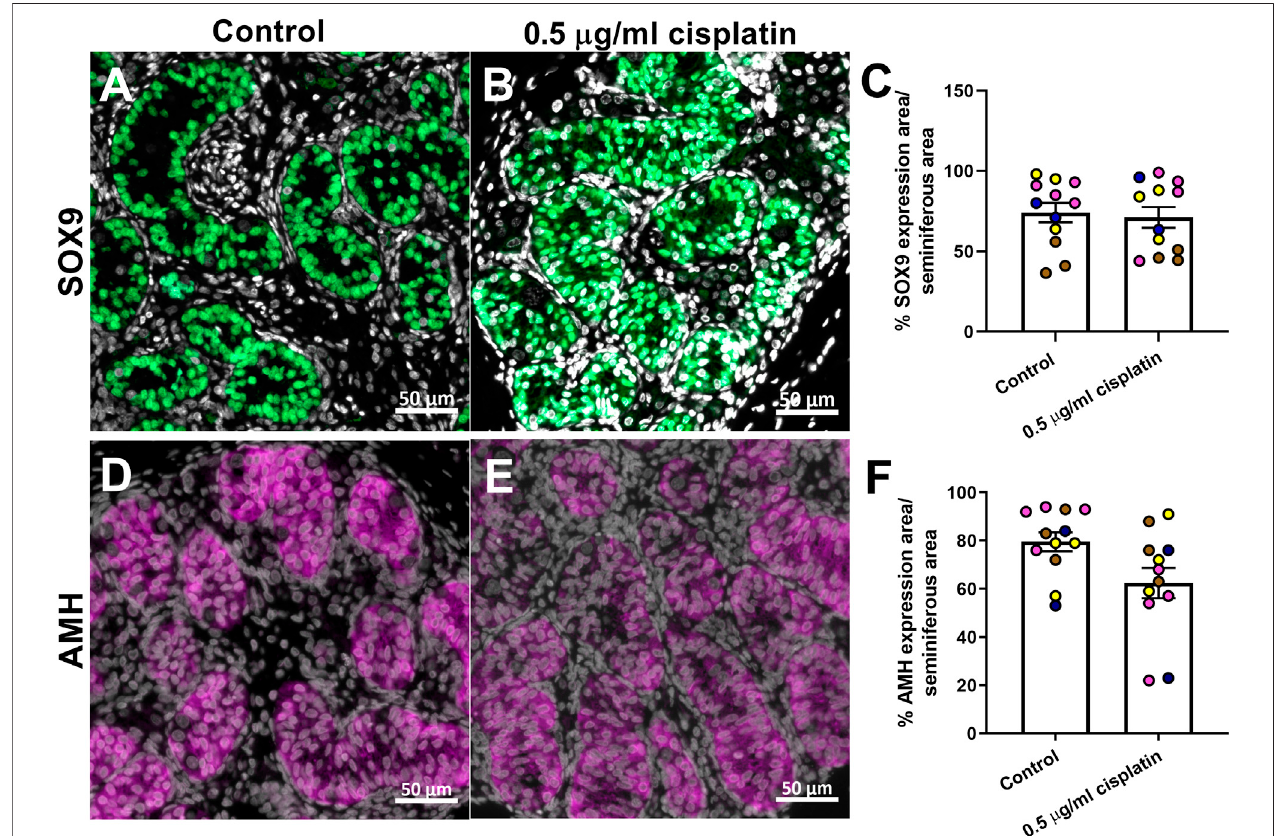
FIGURE 5 | Long-term effects of exposure to cisplatin on Sertoli cells in the human fetal testicular tissue xenografts. SOX9 [green; (A,B) ] and anti-M ϋ llerian hormone [AMH; purple, (D,E) ] protein expression in the human fetal testicular tissues exposed to vehicle control or 0.5 μ g/ml cisplatin for 24 h prior to xenografting (12 weeks).Scalebarsrepresent50 μ m.Quanti fi cationofpercentageofcordareaexpressingSOX9 (C) orAMH (F) inxenografts.Exposureto0.5 μ g/mlcisplatindidnot havealong-termeffectonthepercentageofcordareaexpressingSOX9orAMH.Dataanalysedusingtwo-wayANOVA.Valuesshownaremeans±SEMandeach of coloured data points represents an individual fetus ( n =